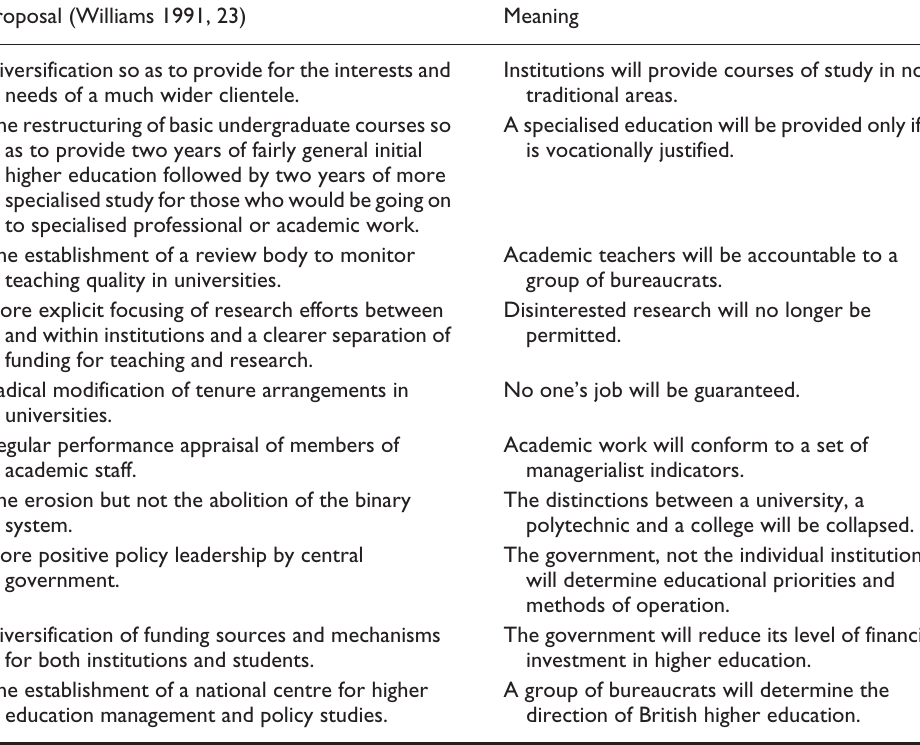
Proposal (Williams 1991, 23)